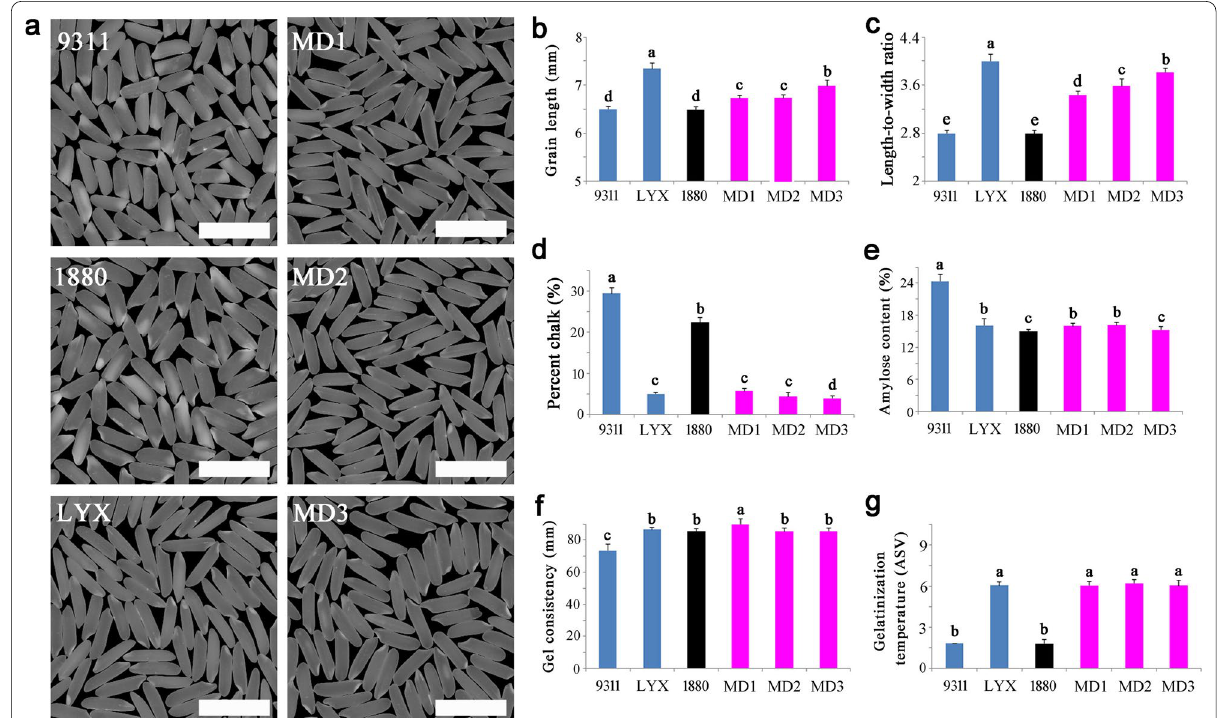
Fig. 5 Rice quality performance of molecular design breeding lines and their parents. a : The performance of the milled grain. Scale bar, 1 cm. b : Grain length. c : Length-to-width ratio. d : Chalky grain rate. e : Amylose content. f : Gel consistency. g : Gelatinization temperature, which is represented by the alkali spreading value (ASV). Values are the means level by the least significant difference